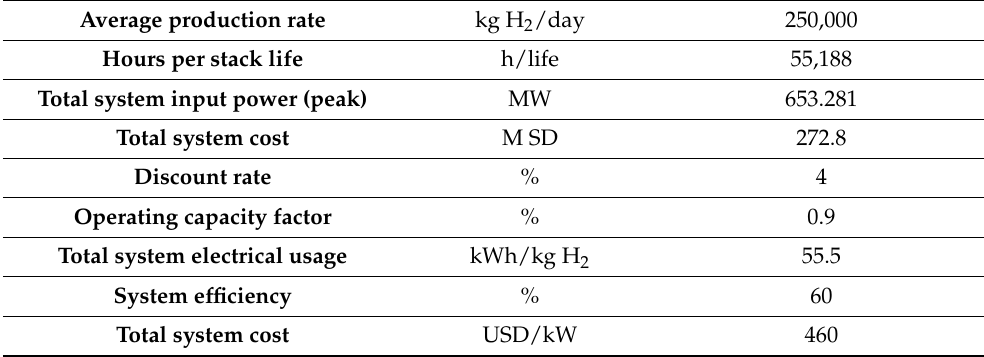
Table 5. H 2 production plant